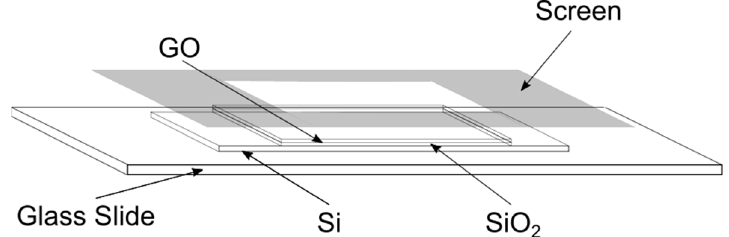
Figure 2. Scheme of the sample cell.